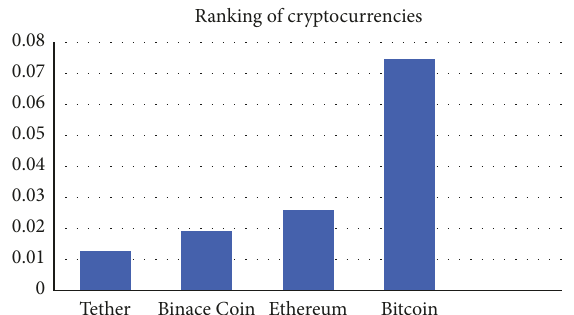
Figure 5: Overall ranking of cryptocurrency.